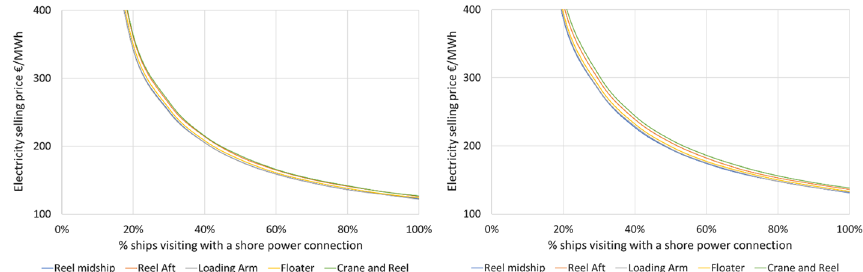
Fig. 5 Break-even shore power price in function of ships with shore power (1 CMS left, 2 CMS right). A similar set of graphs can be created for the port side. See Source :